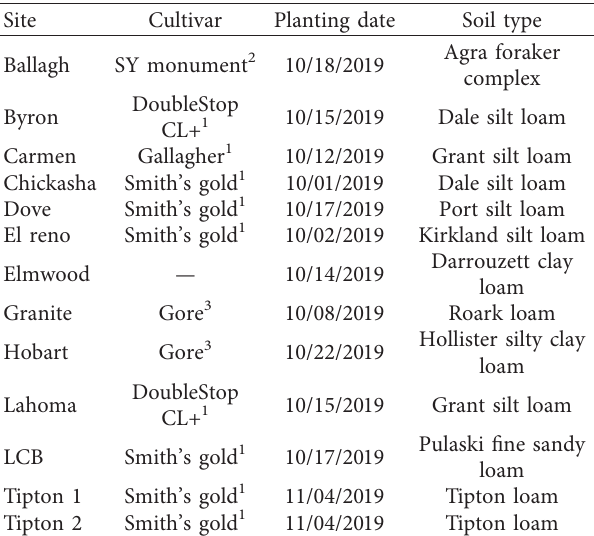
Figure 1: Map of all locations. Each point denotes location, in total 13. Inset shows the location of Oklahoma inside the contiguous United States. Table 1: Site name, cultivar, planting date, and soil type of each location of the